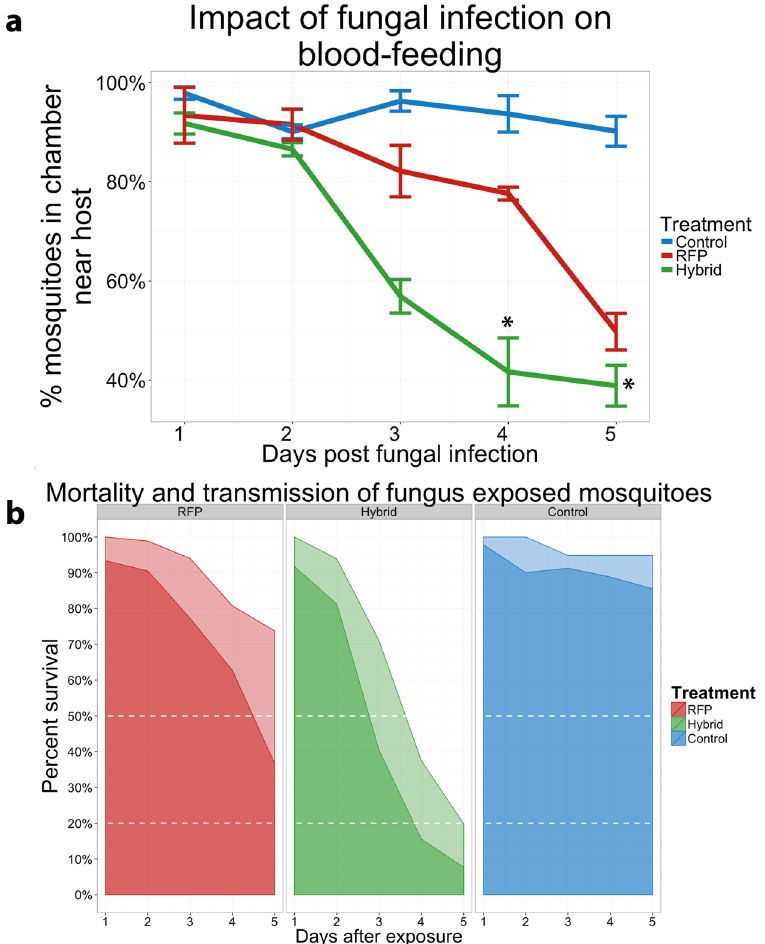
Figure 3. ( a ) Impact of fungal infection on blood-feeding at 1–5 days post-infection with either Met-Hybrid or Met-RFP. Mosquitoes were placed in a choice chamber with the guinea pig host outside of the chamber and just out of reach (Supplementary Figure 1a,b). Host-seeking (blood feeding) interest was quantified as the percentage of the mosquito population choosing the chamber closest to the host. The symbol “ * ” denotes no significant differences in mosquito choices with or without a host: 30 ± 3.05% of the mosquitoes chose the “host” chamber even in the absence of a host. ( b ) Mortality and transmission of mosquitoes exposed to fungus, the light area represents the percent survival of mosquitoes for each treatment, while the dark area shows the proportion of mosquitoes in each treatment that are alive and would seek a host to blood feed (capable of malaria transmission). The upper dashed line represents the LT50 while the lower dashed line represents the 80% control threshold suggested by the World Health Organization (WHO) for a successful vector control agent 18